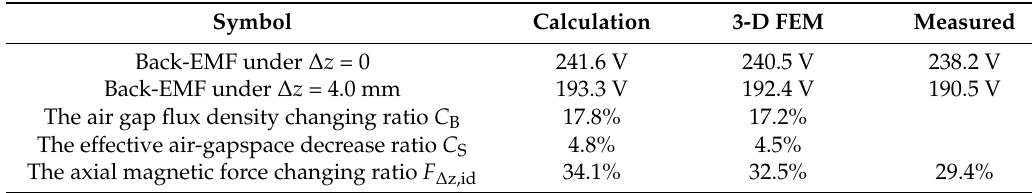
Table 4. The back-EMF and axial magnetic force changing